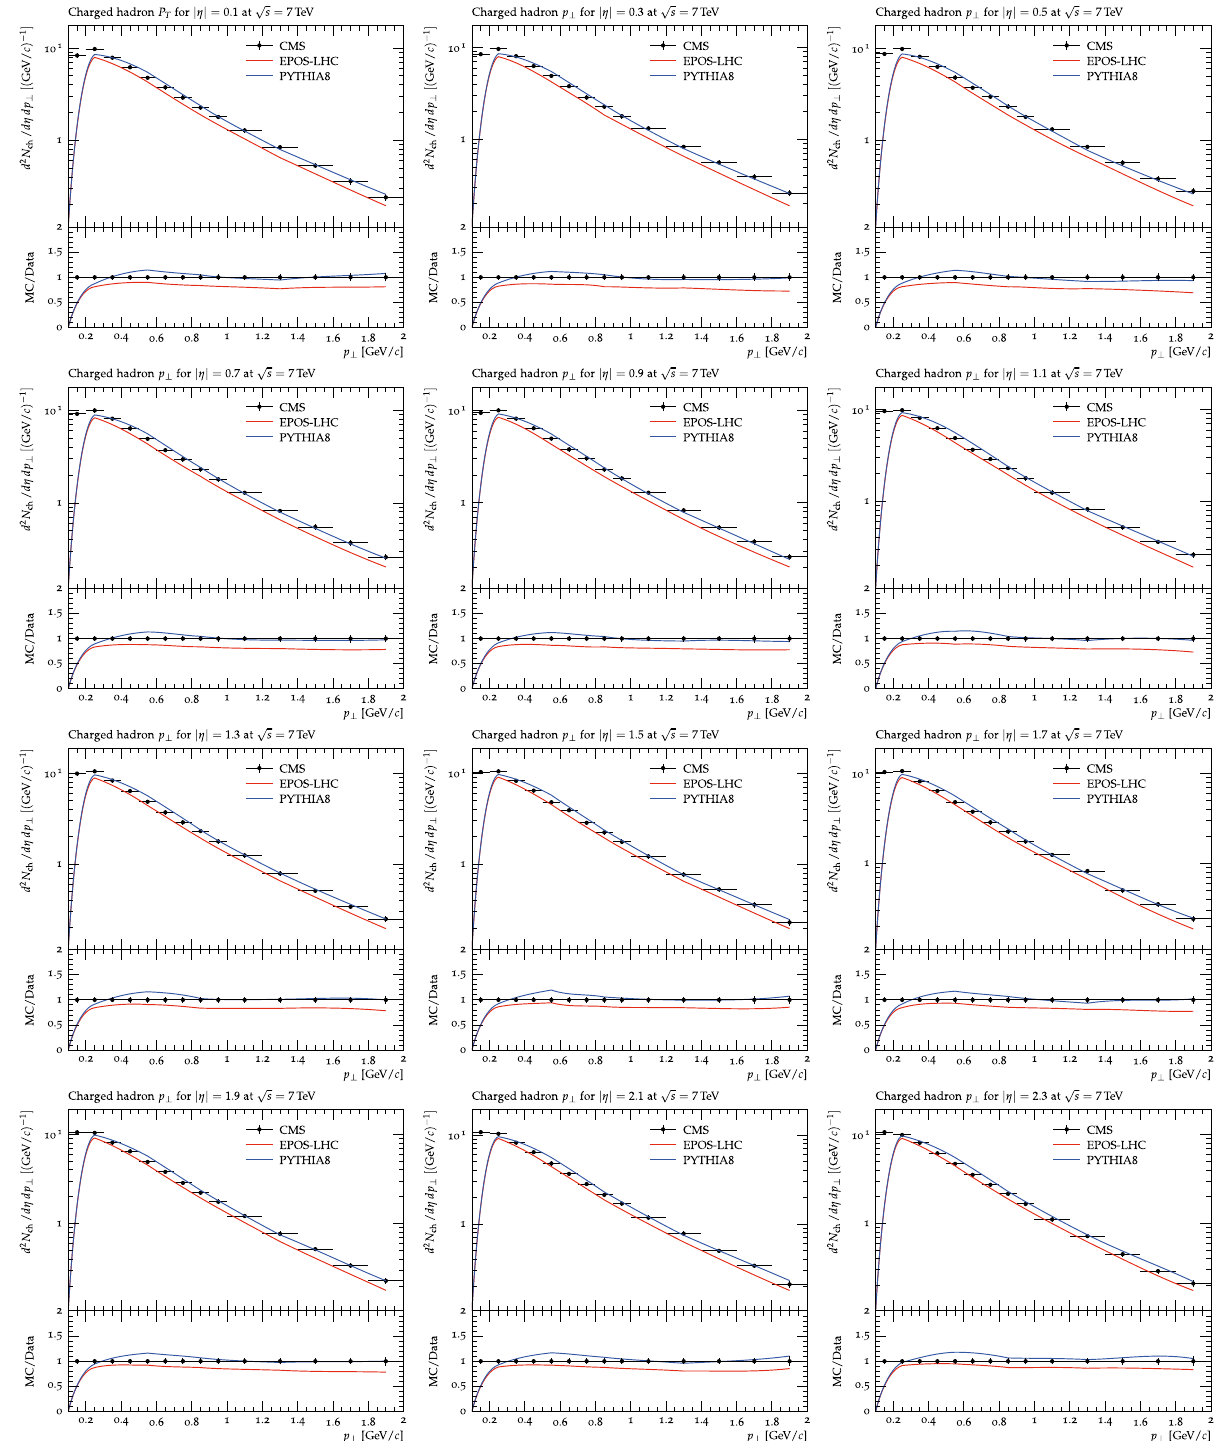
Figure 1. The p T spectra of all charged hadrons are presented at different pseudorapidity bins measured by the CMS experiment in comparison with the prediction of EPOS and Pythia models. Black solid markers represent the experimental measurements while lines of different colors show the models’ predictions. Blue line shows the Pythia while the red line is used for the EPOS model’s